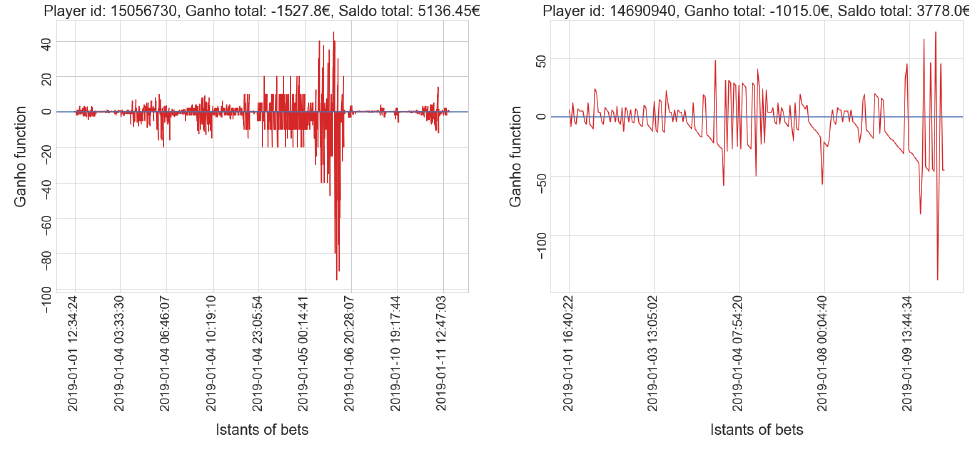
Figure 24. Time series plot of two potential medium-risk pathological